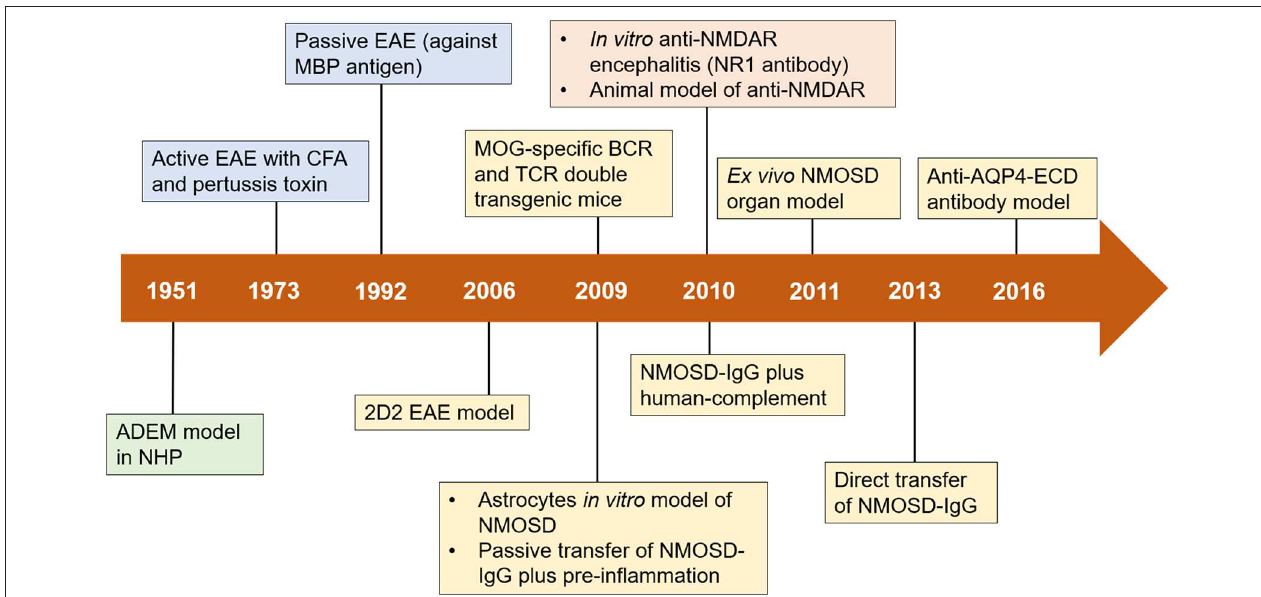
FIGURE 1 | Timeline of advances in preclinical models of neuroimmune diseases. Important milestones in the development of preclinical models are shown in green boxes (for ADEM), blue boxes (for MS), yellow boxes (for NMOSD), and orange boxes (for anti-NMDAR encephalitis). ADEM, acute disseminated encephalomyelitis; AQP4, aquaporin-4; BCR, B cell receptor; CFA, complete Freund’s adjuvant; EAE, experimental autoimmune encephalomyelitis; ECD, extracellular domains; MBP, myelin basic protein; MOG, myelin oligodendrocyte glycoprotein; NHP, nonhuman primate; NMDAR, N-methyl-D-aspartate receptor; NMOSD, neuromyelitis optica spectrum disorders; TCR, T cell receptor; IgG, immunoglobulin